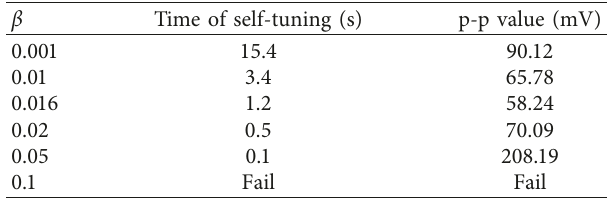
Table 3: Comparison of vibration damping results with changing β .